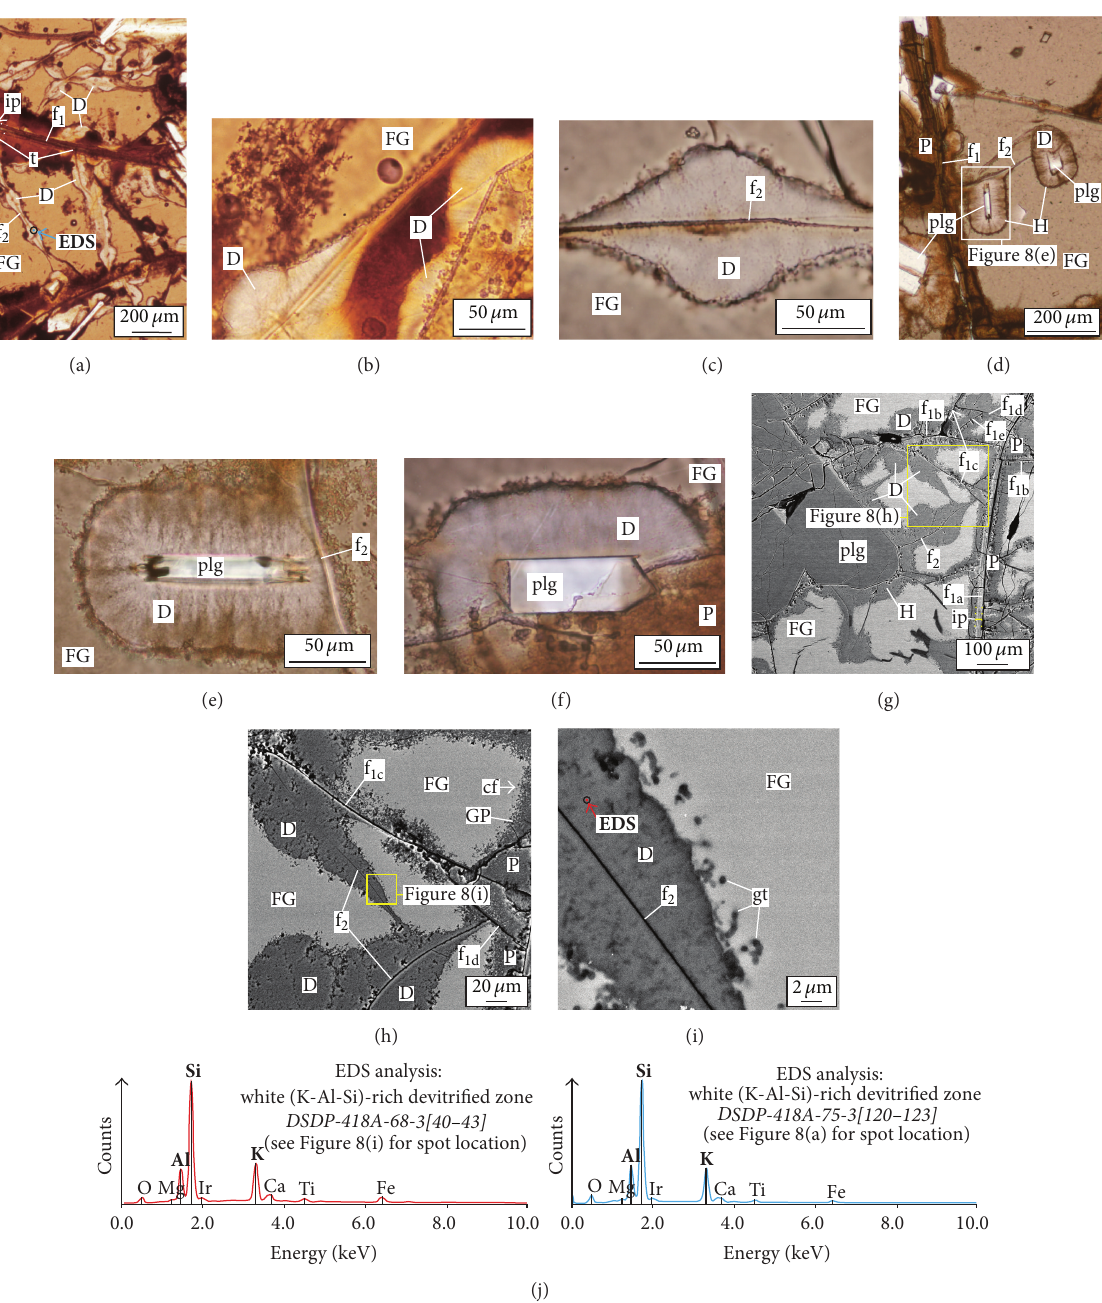
Figure 8: Petrographic and SEM study of white (K-Al-Si)-rich devitrified zones (in thin section). (a–f) Photomicrographs in plane polarized light, highlighting development of “lip-shaped” (K-Al-Si)-rich devitrified zones along late (f 2 ) fractures (a–c), as well as halos around some plagioclase crystals (d–f). (a, b): sample DSDP-418A-75-3[120–123] ; (d, e): sample DSDP-418A-68-3[40–43] ; (c, f): sample DSDP-418A-72- 4[13–15] . (g–i) SEM (BSE) images of a polished thin section of sample DSDP-418A-68-3[40–43] , highlighting white (K-Al-Si)-rich